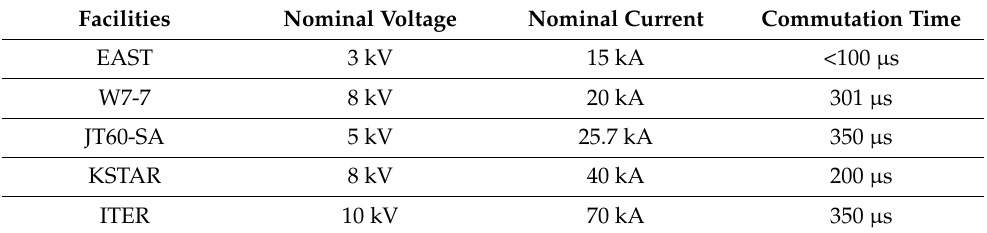
Table 1. The main parameters of the pyro-breakers in different QPSs.